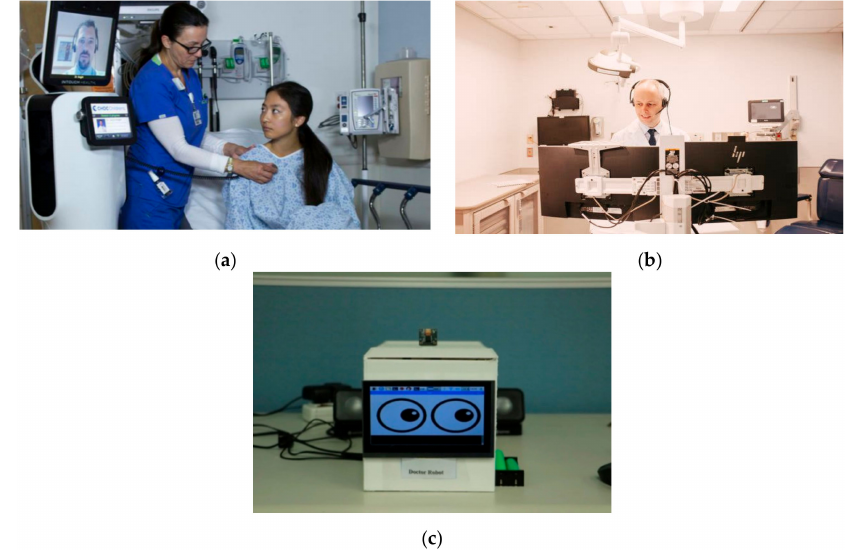
Figure 7. Telemedicine Robots for real-time remote patient assistance. (a) RP-VITA: FDA approved first autonomous telemedicine robot [43]. (b) Dr. Paul Casey, taking video calls at Rush University Medical Center [44]. (c) Doctor Robot for telemedicine